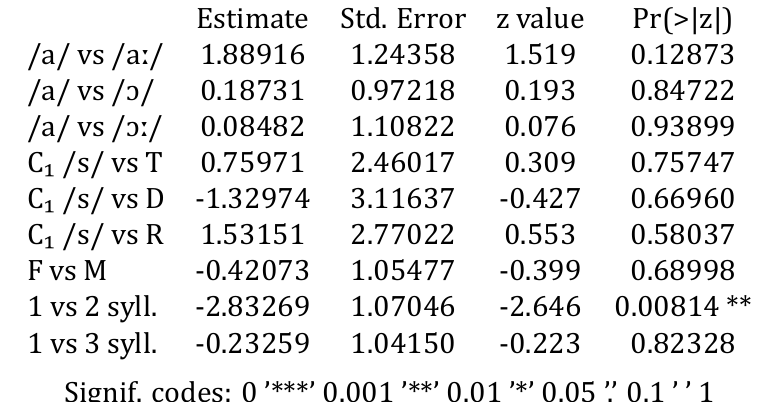
Table A.20: Breathiness occurrence prior to C₂ fortis plosive as a dependent variable